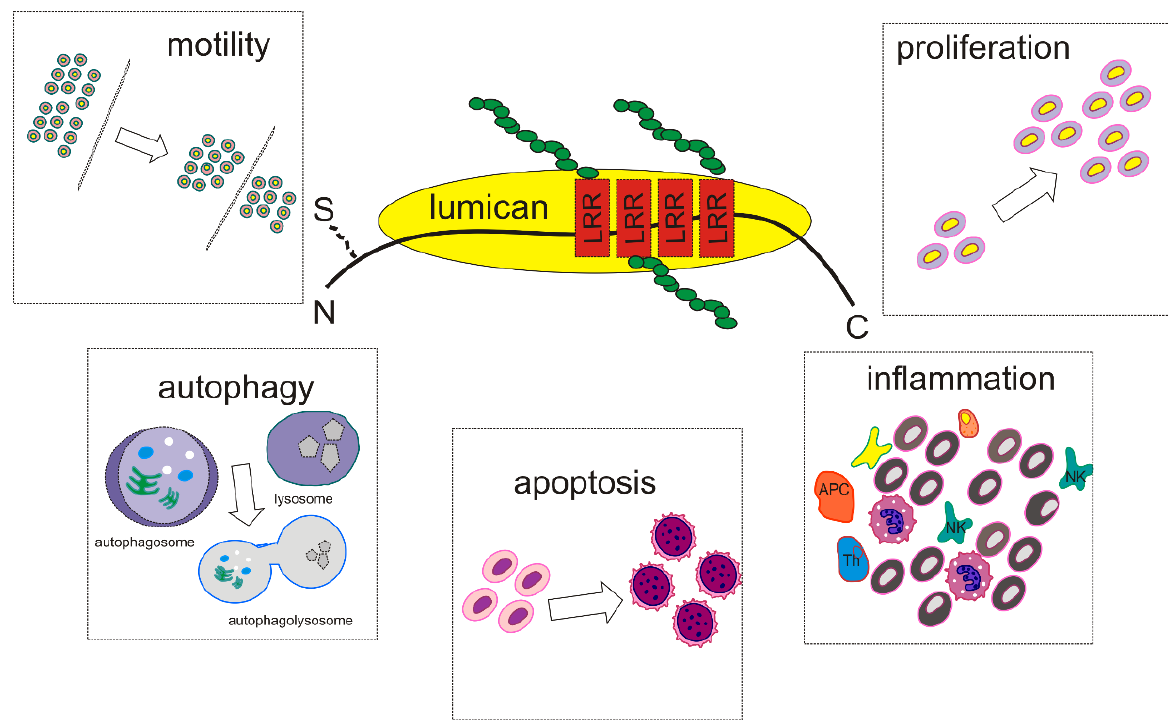
Figure 2. Lumican affects cancer cell behavior.Lumican alters cancer cell proliferation, migration, adhesion, invasion, metastasis, and apoptosis, and affects autophagy and inflammation signaling pathways with different mechanisms.